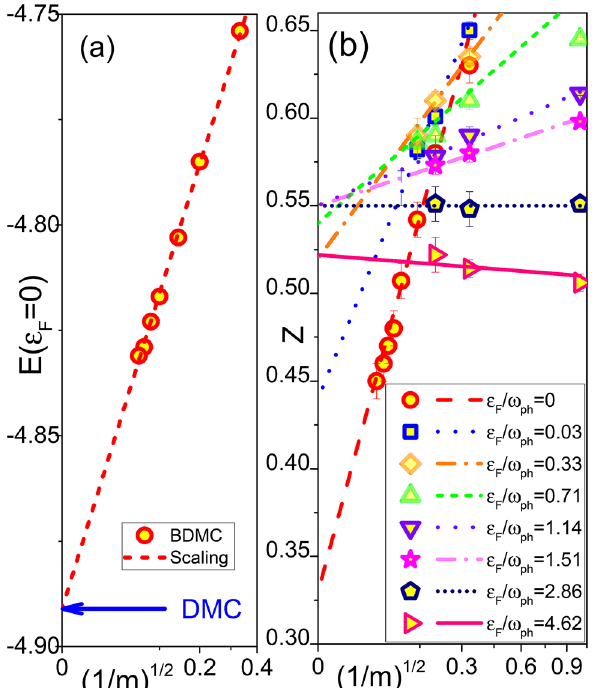
Figure 5. Finite expansion-order corrections to the polaron energy ( a ) and QP residue ( b ) revealing linear b / √ m (dashed line) for the ground state scaling with m − 1 / 2 . ( a ) BDMC data (circles) and the scaling law a + 4 . The DMC result at δ 3.8 10 0 is shown by the blue arrow. ( b ) BDMC data (symbols) and energy at δ − = × = b / √ m (lines) for the quasi-particle the scaling laws a +